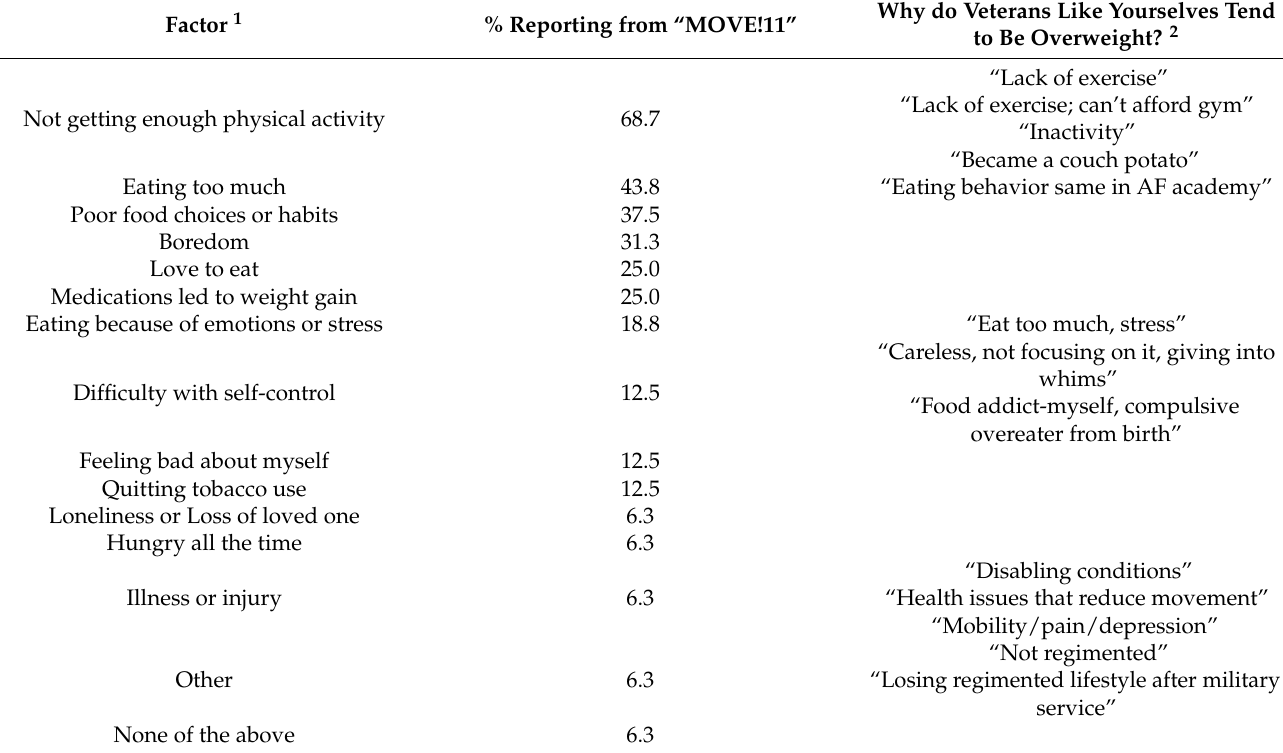
Table 3. Factors contributing to overweight status reported by older Veterans with dysmobility enrolled in an exercise and nutrition randomized controlled trial ( n =